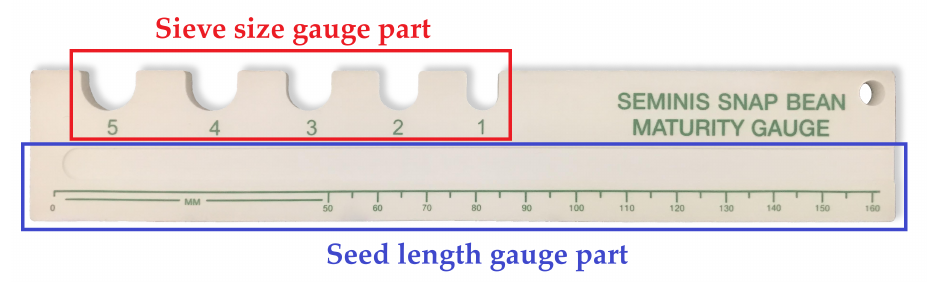
Figure 3. Maturity gauge used for determining seed length and pods’ sieve sizes. On the upper part, pod sieve size is determined by sliding pods across the cavities. On the bottom part, ten seeds are put alongside each other and the total length is recorded.